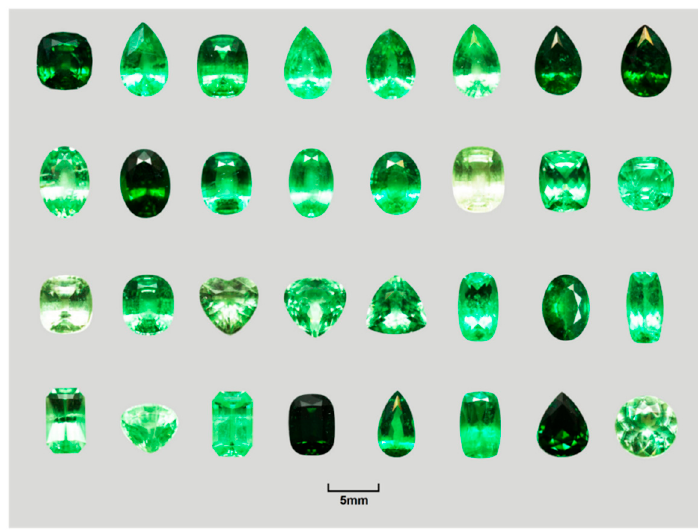
Figure 1. Some of tsavorite samples with various tones used in this